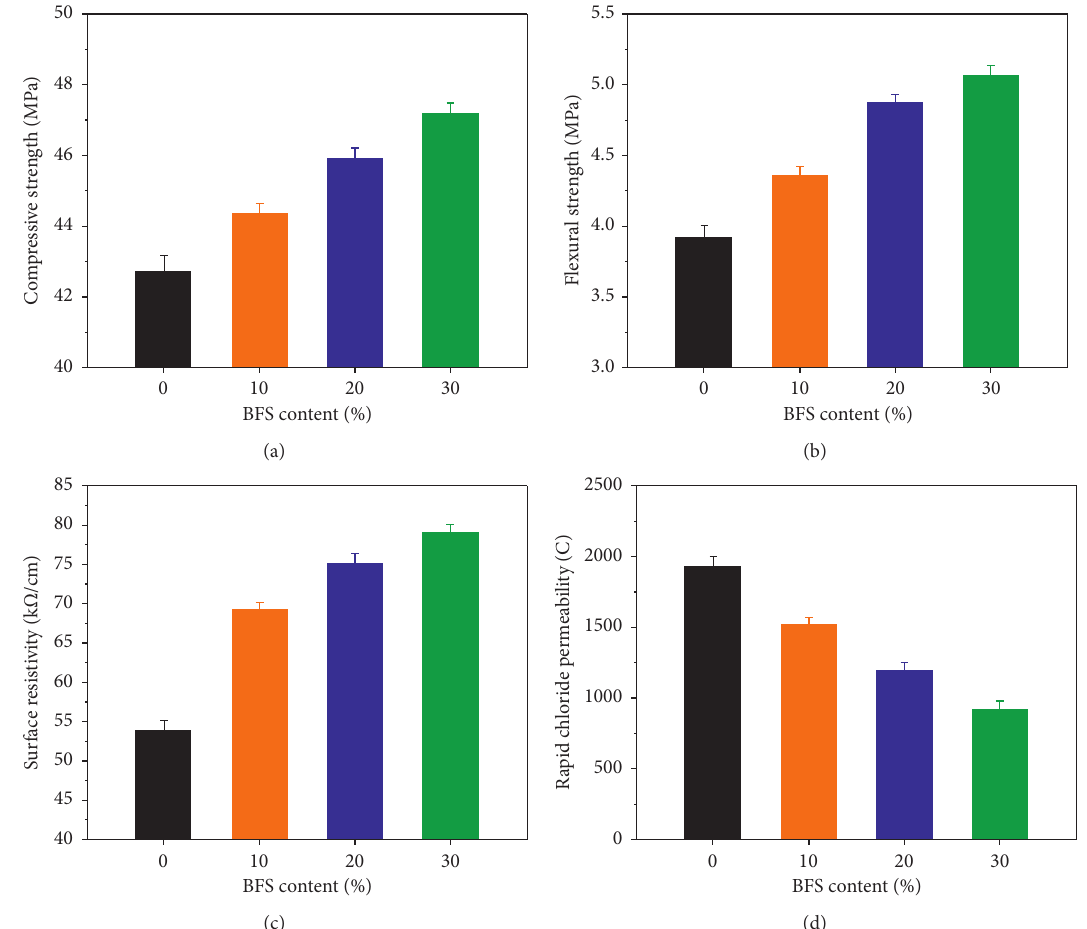
Figure 6: Influence of single-mineral admixture-BFS on the performances of concrete. (a) Compressive strength. (b) Flexural strength. (c) Surface resistivity. (d) Rapid chloride permeability.